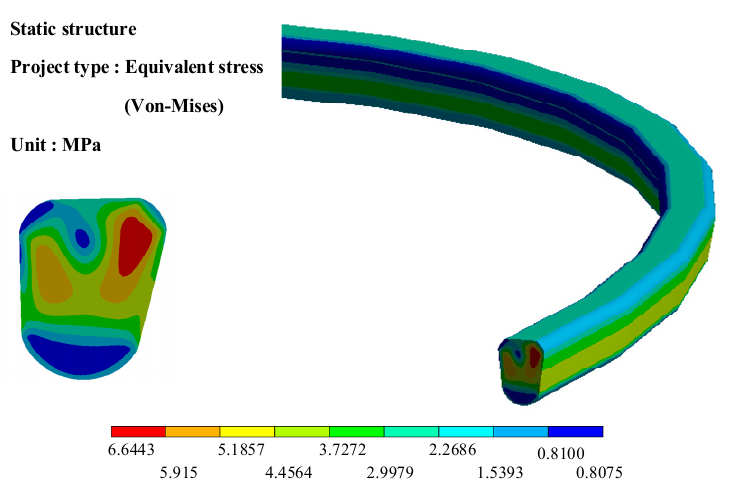
Figure 8. Nephogram of O-ring von Mises stress under no pressure.